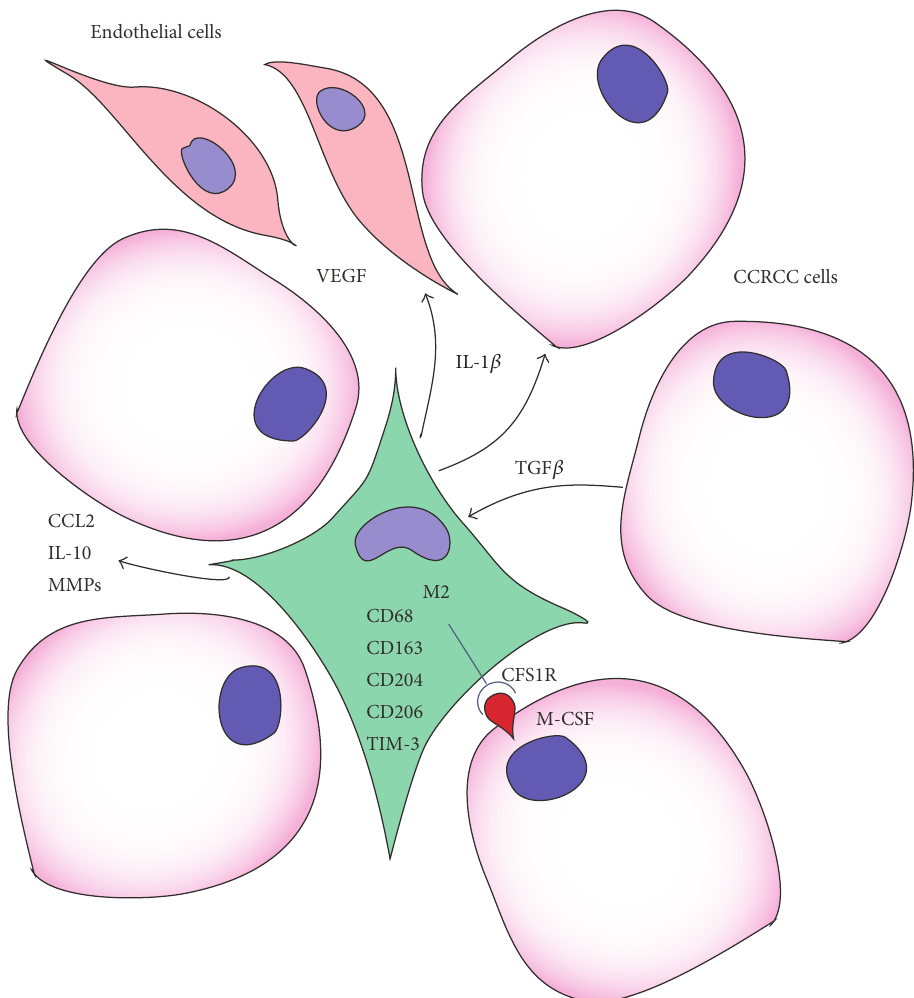
Figure 1: Interaction between tumor cells, tumor associated macrophages, and endothelial cells in renal cell